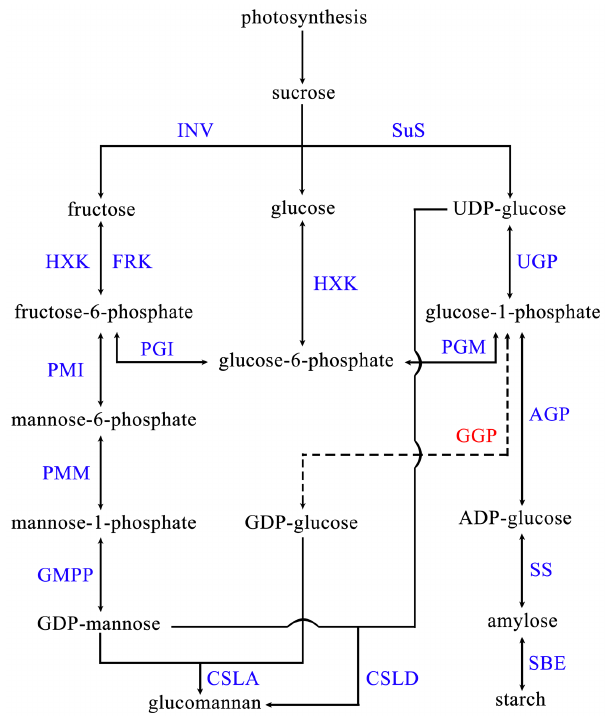
Figure 8. Proposed pathways of konjac glucomannan biosyn- thesis. The identified enzymes in Amorphophallus are noted in blue and the unidentified is in red. Sucrose synthase (SuS), invertase (INV), phosphoglucose isomerase (PGI), phosphoglucomutase (PGM), phos- phomannose isomerase (PMI), phosphomannomutase (PMM), starch synthase (SS), GDP-mannose pyrophosphorylase (GMPP), UDP-glucose pyrophosphorylase (UGP), ADP-glucose pyrophosphorylase (AGP), fructokinase (FRK), hexokinase (HXK), starch branching enzyme (SDB), cellulose synthase-like A (CSLA), Cellulose synthase-like D (CSLD), GDP- D-pyrophosphorylase (GGP)